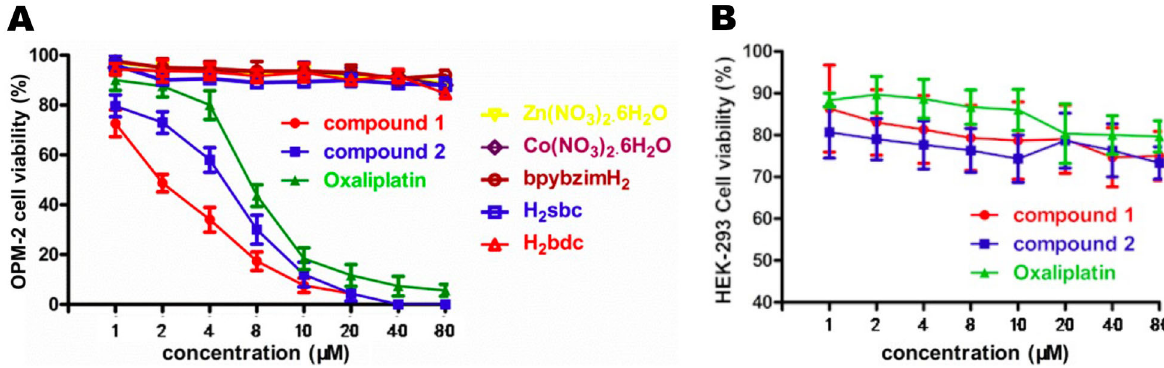
Figure 5. Compounds 1 and 2 inhibited OPM-2 cell proliferation. A , Cell viability curves were measured by CCK8 assay after treatment with compounds 1 and 2, Zn (NO 3 ) 2 (cid:2) 6H 2 O, Co (NO 3 ) 2 (cid:2) 6H 2 O, bpybzimH 2 , H 2 sbc, and H 2 bdc for 24 h. B , The half inhibitory concentration (IC 50 ) of compounds 1 and 2 against HEK-293 cells. Data are reported as means ±